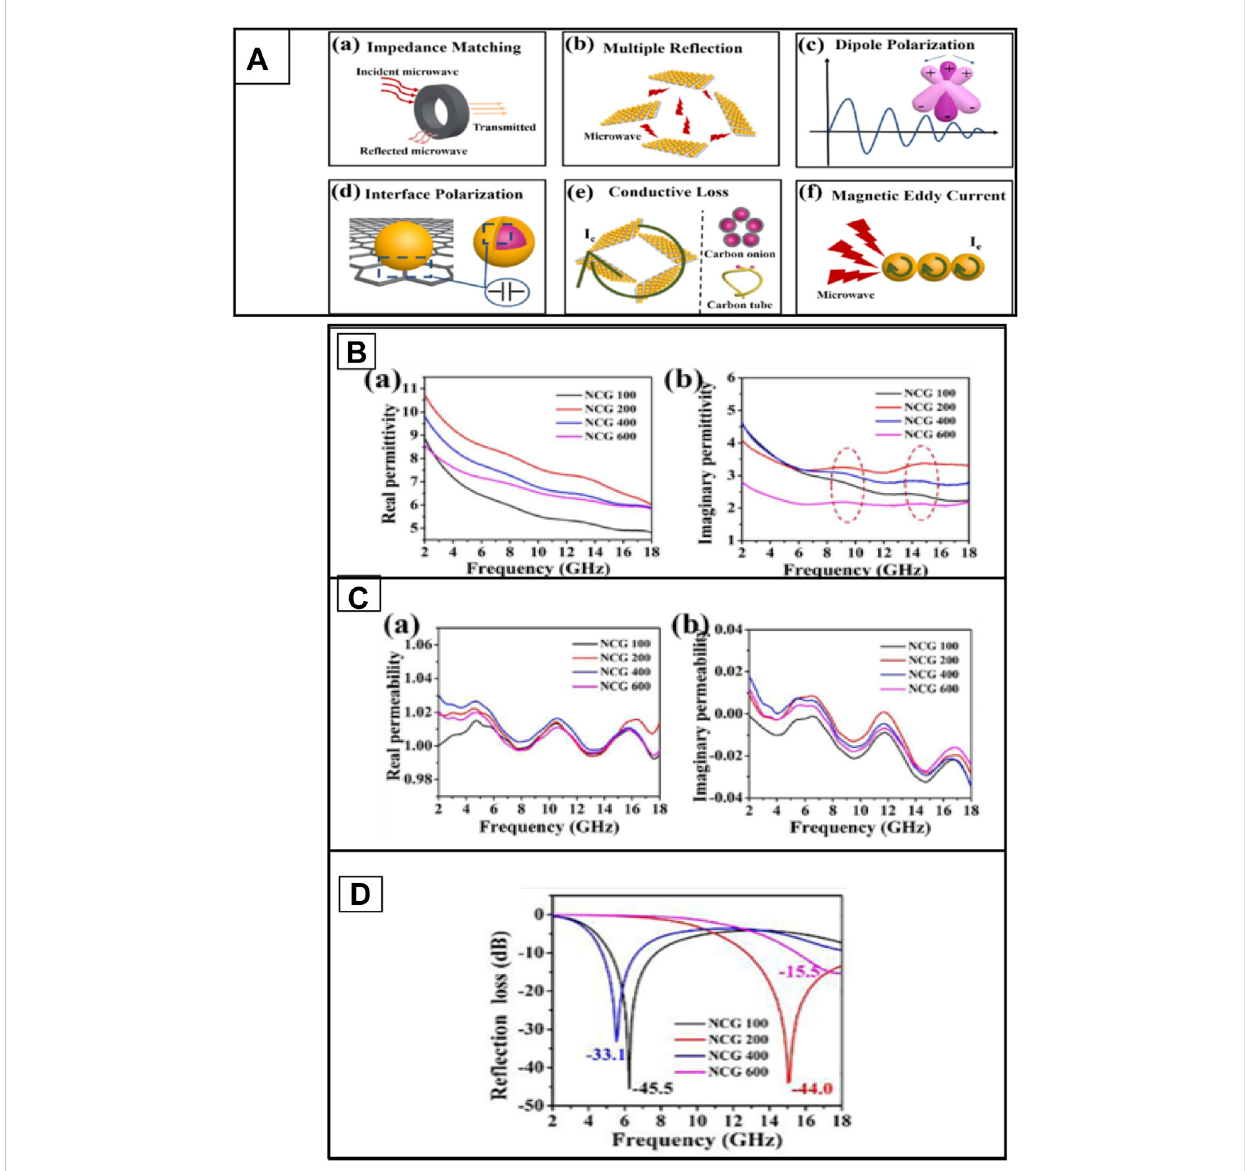
FIGURE 3 (A) Schematic illustration of theprimary microwave-absorbing mechanismsintheNi@C/Gand Ni/CNT/G absorbers, (Ba,b) realand imaginary parts ofthepermittivityofthesamples, (Ca,b) complexpermeability versus frequencyofNCG100,NCG200,NCG400,andNCG600,and (D) summarizedRL results of the samples (Xu et al.,